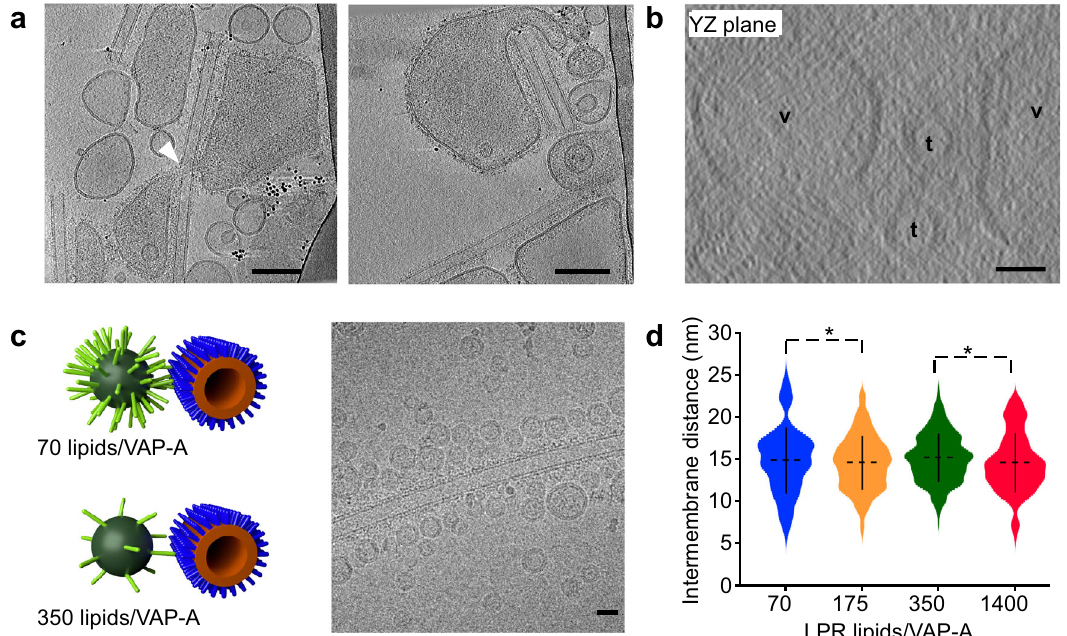
Fig. 3 Membrane deformation upon MCS formation. a Tomographic XY slice from two tilt series showing that VAP-A vesicles spread along the long axis of tubes, form tongue (left fi gure, white arrow) around the tubes, but in general avoid the high curvature short axis of tubes (right fi gure). Bars = 100 nm. b Tomographic YZ slice from a third tilt series showing the fl at membrane of vesicles (v) facing tubes (t). Bars = 25 nm. c Small and non-deformable VAP- A proteoliposomes at varying LPR and bound to N-PH-FFAT tubes. Representative MCS with VAP-A vesicles of 30 nm diameter at 70 and 350 lipids/VAP- A mol/mol. Cryo-EM image of small liposomes of VAP-A at LPR350 lipids/VAP-A forming contact with N-PH-FFAT coated tubes. Bar = 25 nm. d Violin plots showing the distribution of distances between small vesicle of VAP-A at varying LPR and N-PH-FFAT tube. The plots show the complete distribution of values analyzed. The horizontal and vertical lines show the average value and the standard deviation, respectively. ∗ indicates p < 0.05 by unpaired t test. Intermembrane distance between tubes and vesicles at LPR 70 ( n = 55), LPR175, ( n = 240), LPR350 ( n = 491), and LPR1400 ( n = 152) were analyzed. Figure 3d. Type of analysis, unpaired (independent), two-sided (two tails), t test, valid for all plots. p = p value, CI = con fi dential interval. Plot LPR175 vs LPR350: p = 0.0145, CI = [ − 1.0367, − 0.1143]. Plot LPR350 vs LPR1400: p = 0.0375, CI = [0.0341, 1.1404]. A representative result is shown from at least three